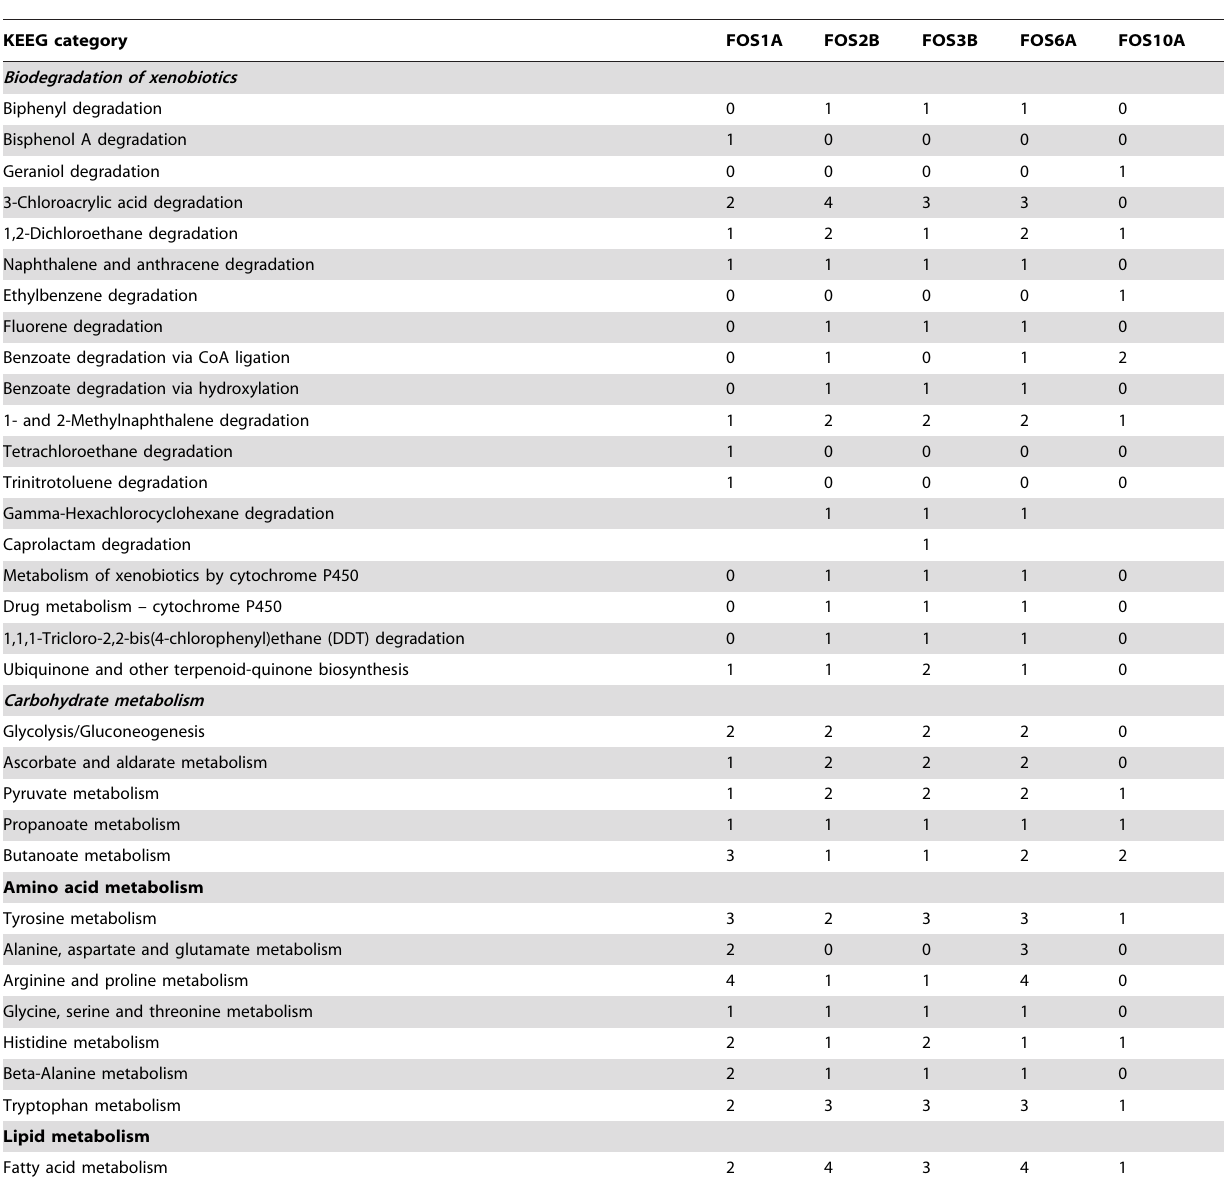
Table 3. Number of sequences of the metagenomic fosmid clones associated with specific functions in KEGG